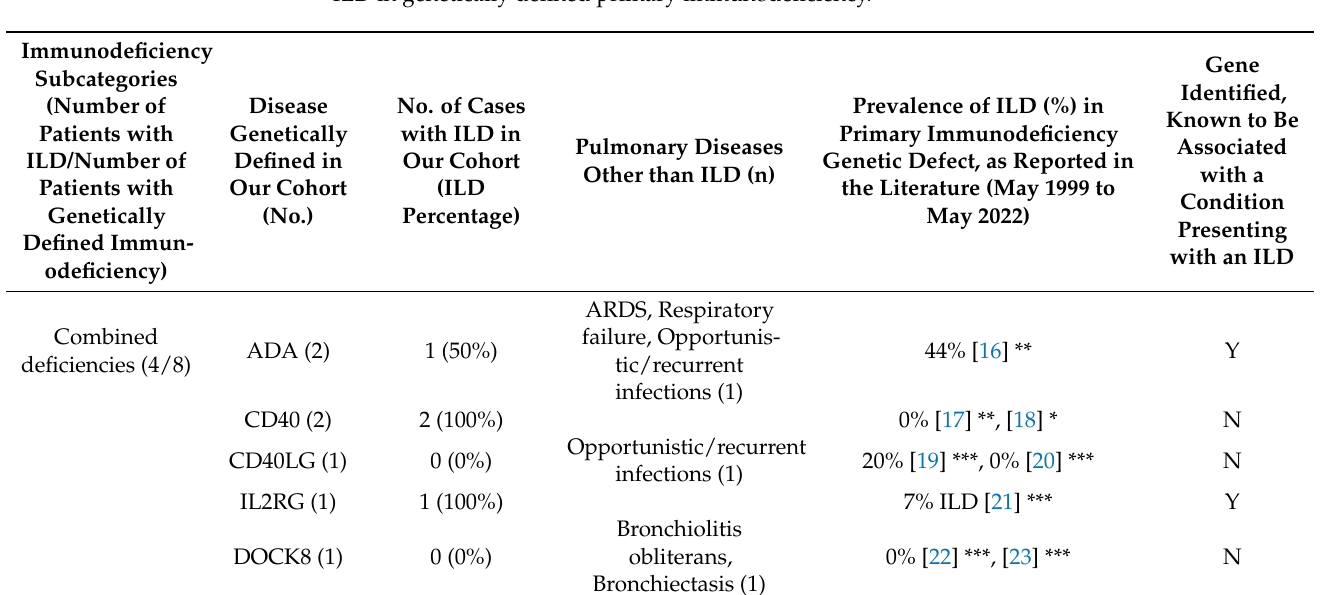
Table 7. Comparison between our cohort and literature regarding the percentage of the presence of ILD in genetically defined primary